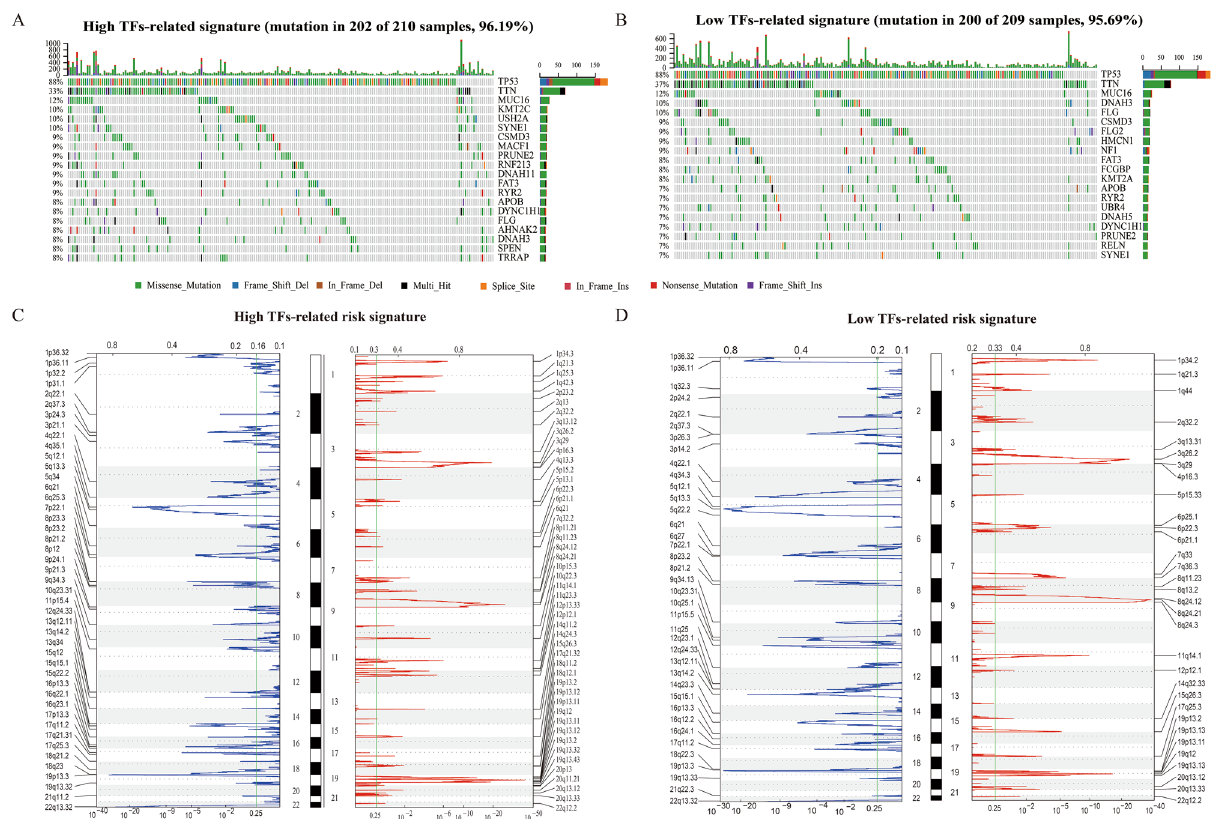
Figure 5. Genetic alterations including somatic mutations ( A , B ) and SCNAs ( C , D ) assigned to high-risk group ( A , C ) and low-risk group ( B , D ); The green line represents the significance threshold ( q value = tration between two clusters (TF1 vs. TF2) was also determined (supplement Fig. 5). The potential response to immunotherapy for each patient was assessed using the TIDE algorithm. The results suggest that patients with